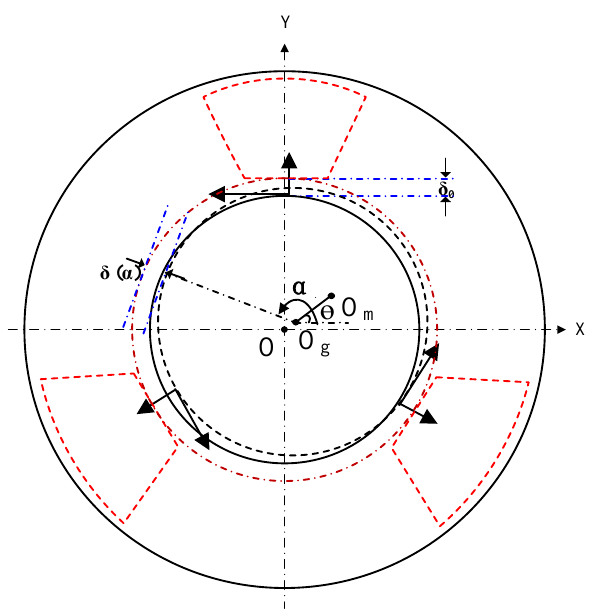
Figure 3. The geometric center misalignment model between the stator and the rotor.